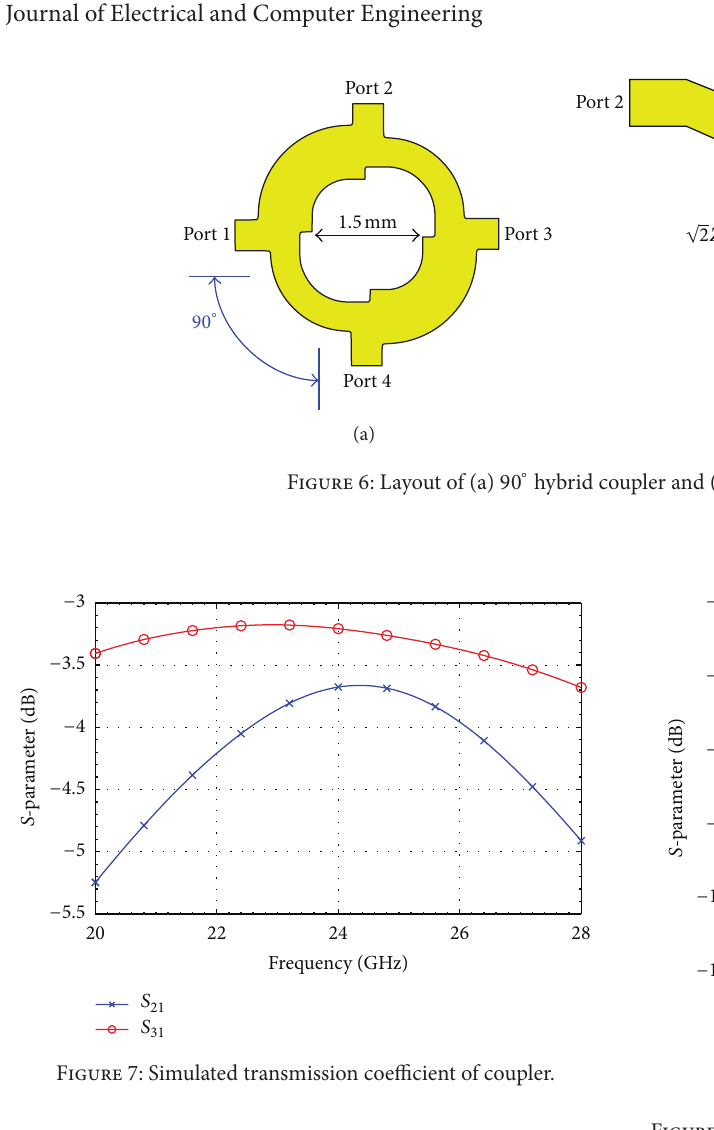
Figure 9: Six-port: simulated transmission from port 1 to the output